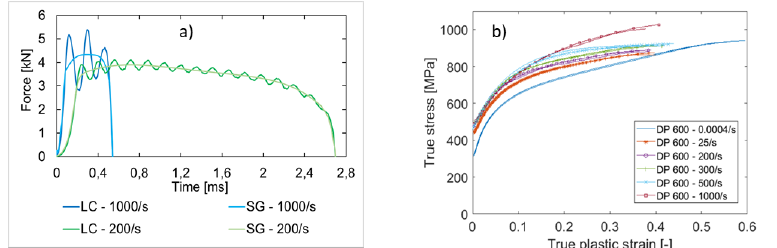
Figure 3: a) Forces measured using load cell and Strain gage (SG) on DP 600 steel (without any filter); b) the corresponding stress strain